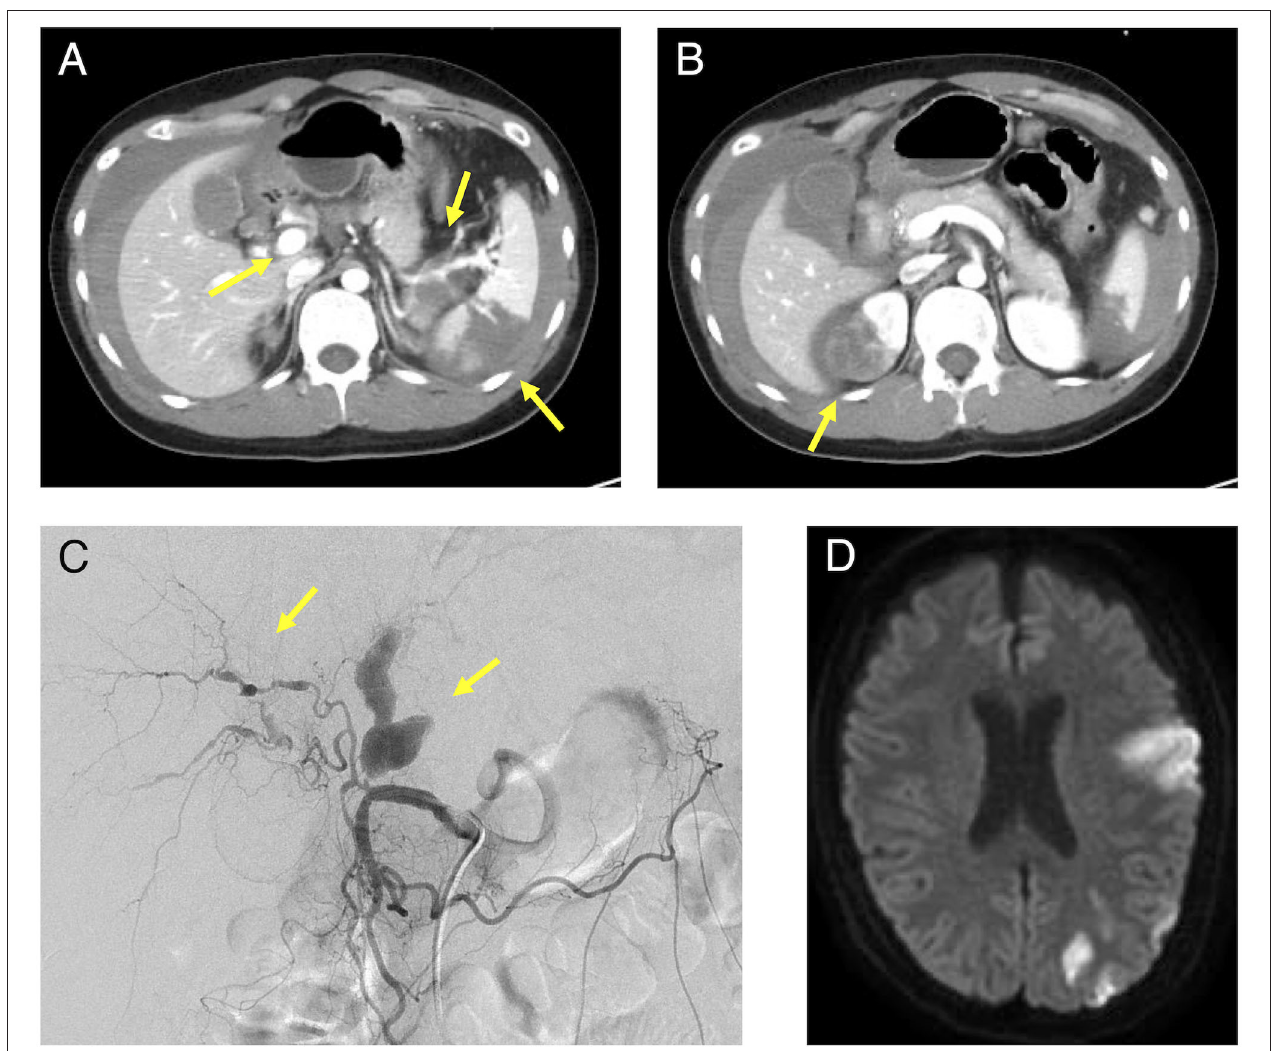
FIGURE 1 | Contrast-enhanced CT, angiography, and head MRI of the patient. (A) : Intra-abdominal hemorrhage, splenic infarction, and hepatic and splenic artery aneurysm were observed in the area indicated by the arrow and (B) : Right renal infarction was observed in the area indicated by the arrow on the contrast-enhanced abdominal CT. (C) : A proper hepatic artery aneurysm was observed in the area indicated by the arrow on angiography. (D) : A cerebral infarction was observed in the left middle cerebral artery territory on the plain MRI of the brain. MRI, magnetic resonance imaging; CT, computed